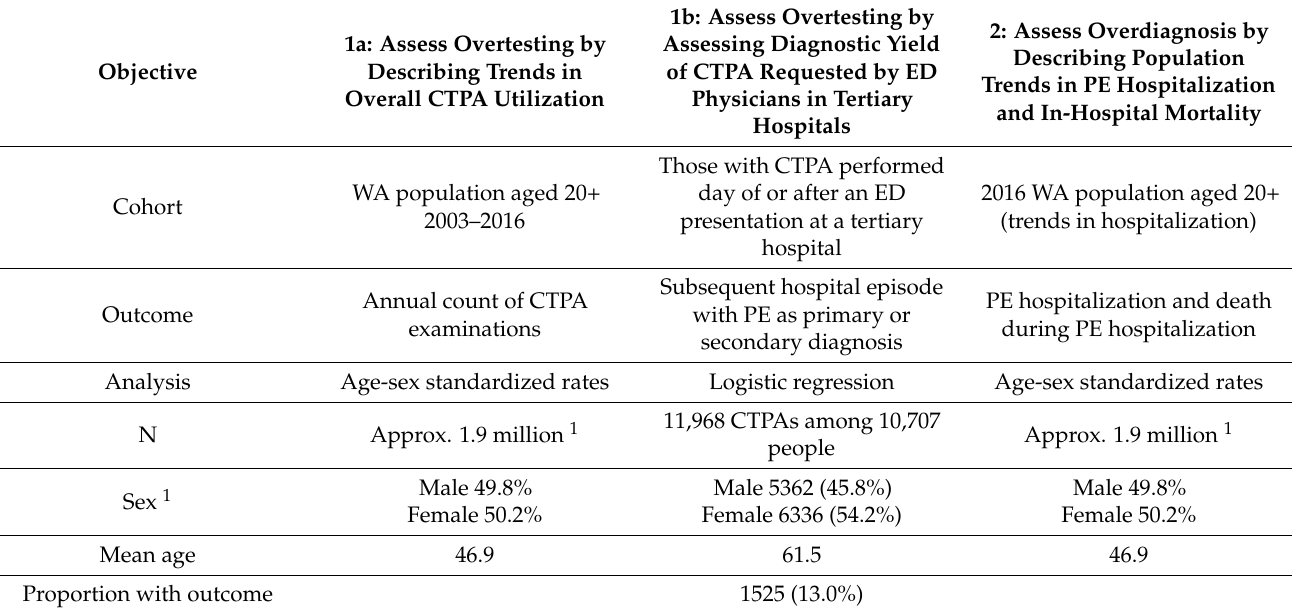
Table 1. Details of the cohorts and outcomes for each analysis, with basic descriptive statistics for